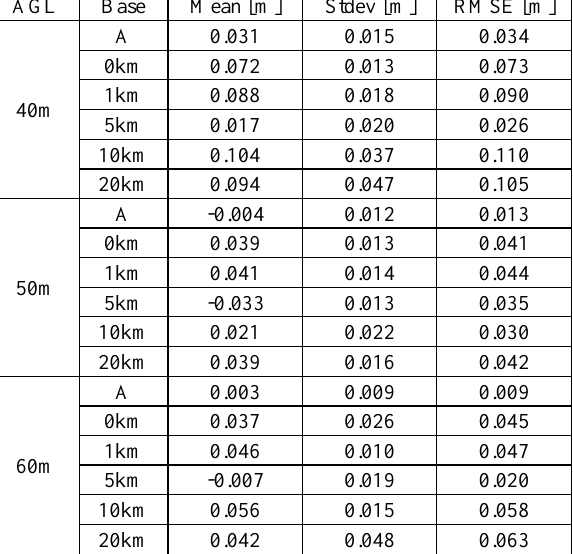
Table 5. Summary statistics of the vertical error Δ H between mensurated and ground surveyed targets. The target count for each row n = 27 except for the 60 m AGL, 20-km baseline flight (n = 26).